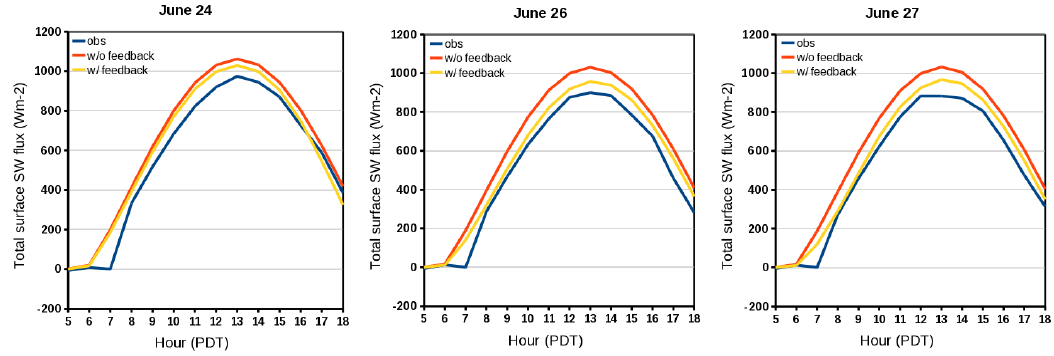
Figure 7. Total surface short wave radiation comparison between measurements at Hanford, CA (blue), and with (yellow) and without (red) direct aerosol feedback